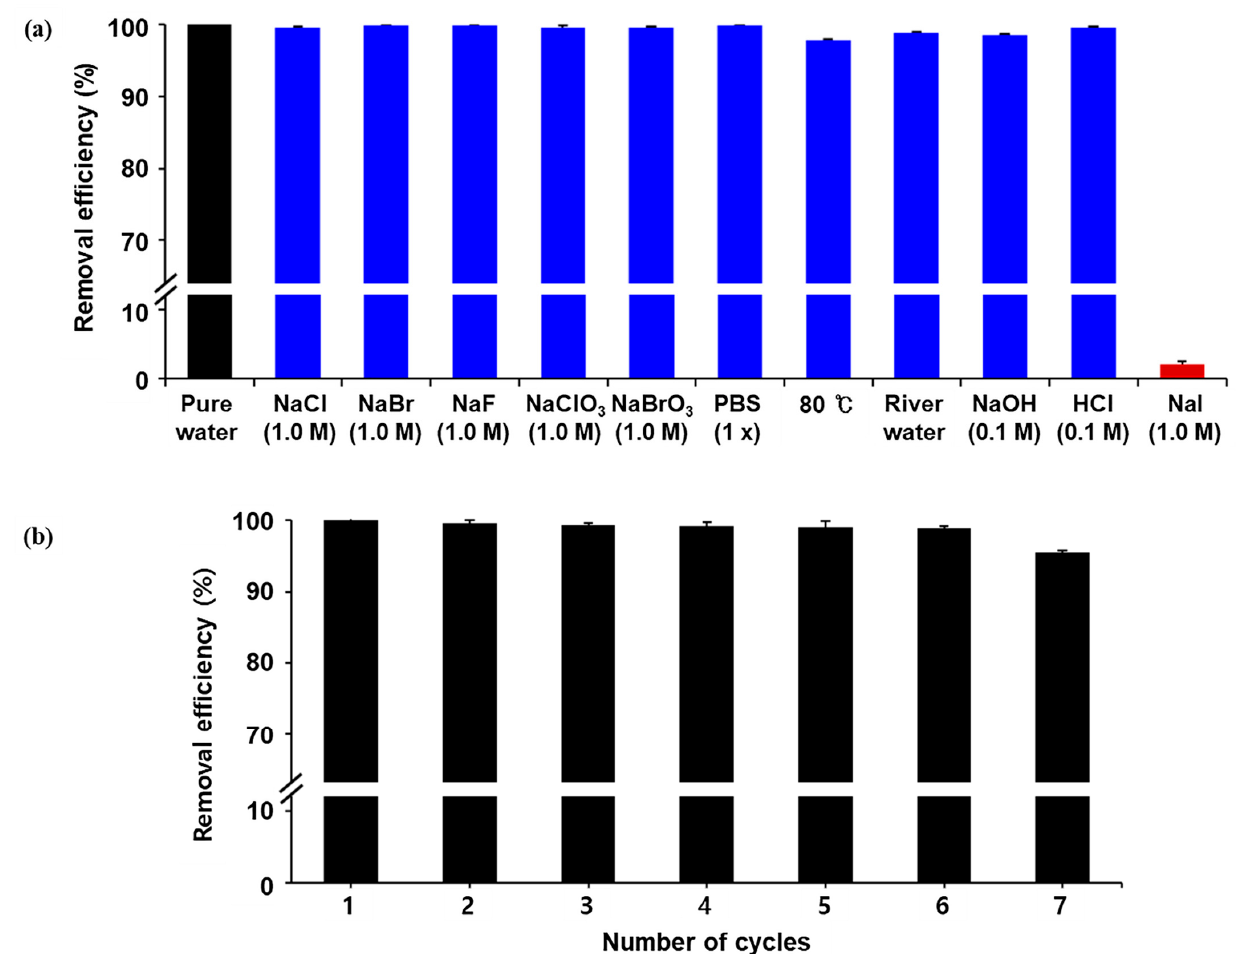
Figure 6. ( a ) Removal efficiency of the Ag/Fe 3 O 4 nanocomposites in the presence of competitive ions, different aqueous solutions, and different pH conditions using radioiodine ( 125 I); ( b ) removal efficiency of the Ag/Fe 3 O 4 nanocomposites using radioiodine ( 125 I) as a function of the number cycles.